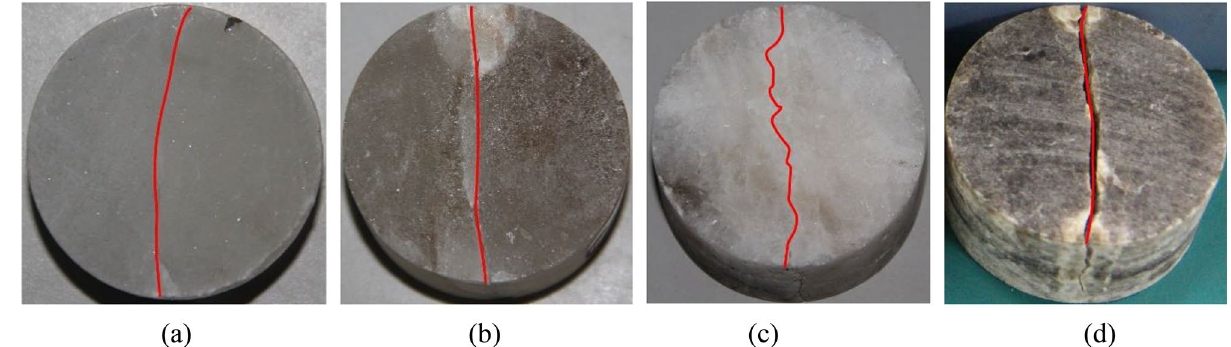
Figure 7. Macro splitting failure characteristics of the four types of gypsum rocks: ( a ) fiber gypsum, ( b ) transparent gypsum, ( c ) alabaster, and ( d ) ordinary gypsum. The red lines represent the fracture lines. (The figure which is not generated by other software are just the photographs of four kinds gypsum rock samples obtained by the camera, and the red line in each sample is drawn to present the difference in failure characteristics for different gypsum